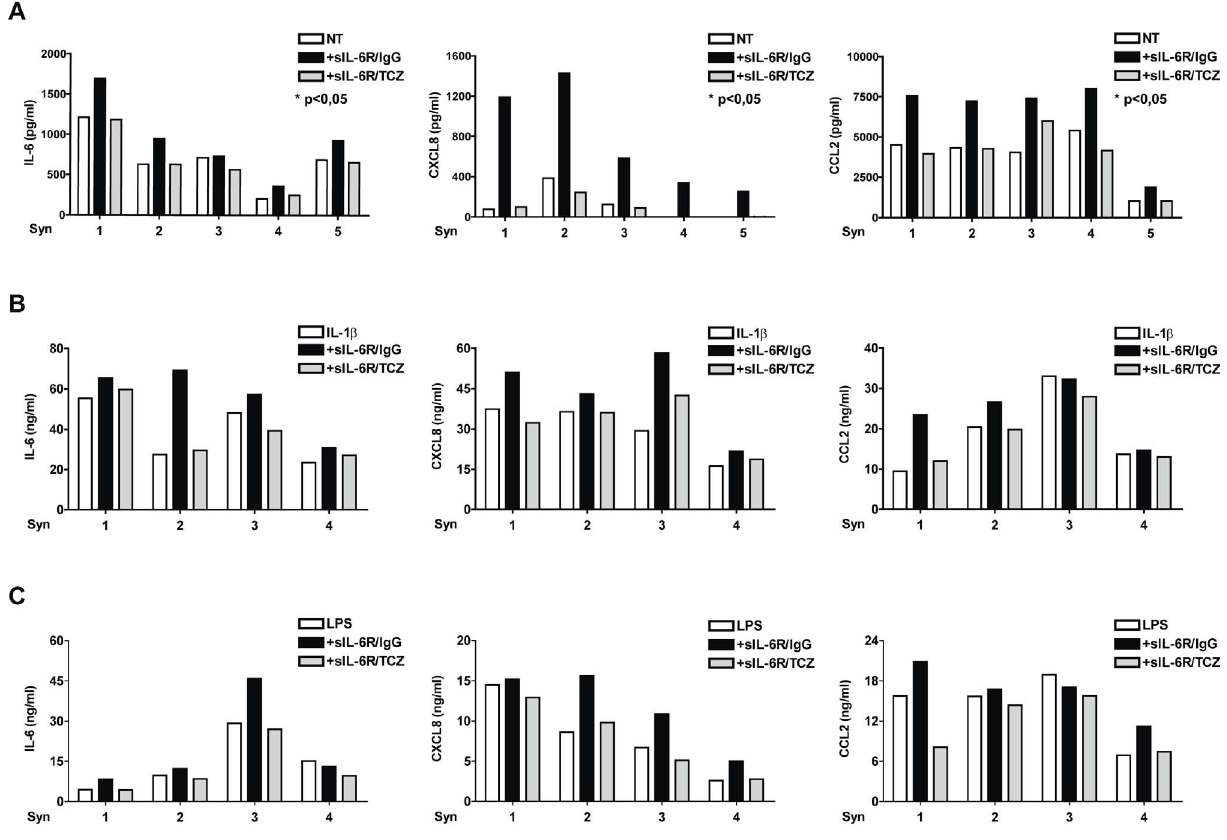
Figure 7. Exposure to sIL-6R enhances cytokine and chemokine production in RA synoviocytes. ( A ) Cells were treated with control IgG1, with sIL-6R in combination with IgG1 (sIL-6/IgG1) or with TCZ (sIL-6R/TCZ) for 18 hours. IL-6, CXCL8 and CCL2 levels were measured by ELISA. ( B–C ) RA synoviocytes were treated with control IgG1, with sIL-6/IgG1 or with sIL-6R/TCZ for 1 hour. Cells were then left untreated or stimulated with IL-1 b (1 ng/ml) ( B ) or LPS (10 ng/ml) ( C ). CXCL8 and CCL2 levels were measured by ELISA. *p , 0.05 for values from IL-6/sIL-6R -stimulated compared with NT cells.